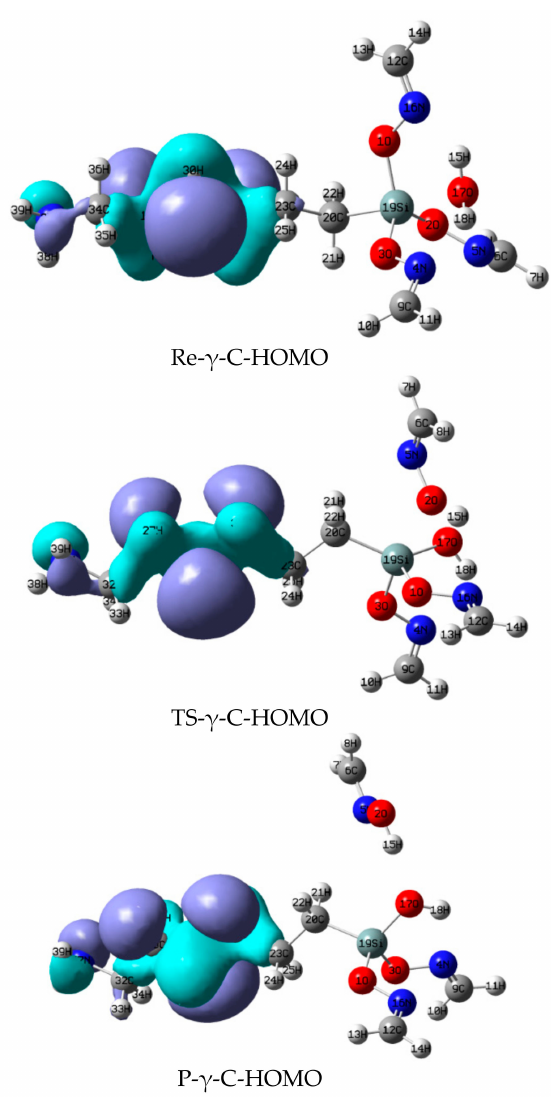
Figure 3. HOMO of stationary points of the reaction between γ -EAMOS and H 2 O at the B3LYP/6-311G**